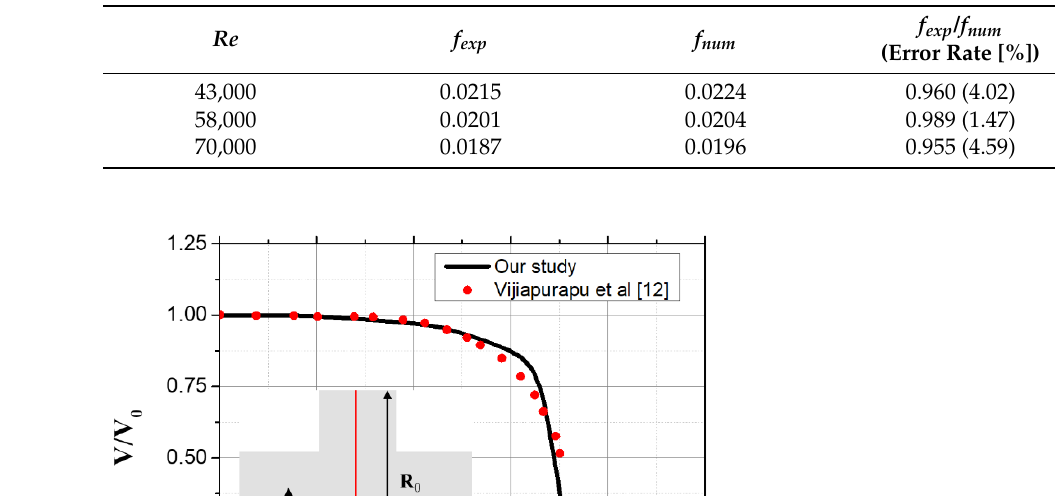
Table 3. Comparison of Experimental results and Numerical results based on friction factor.